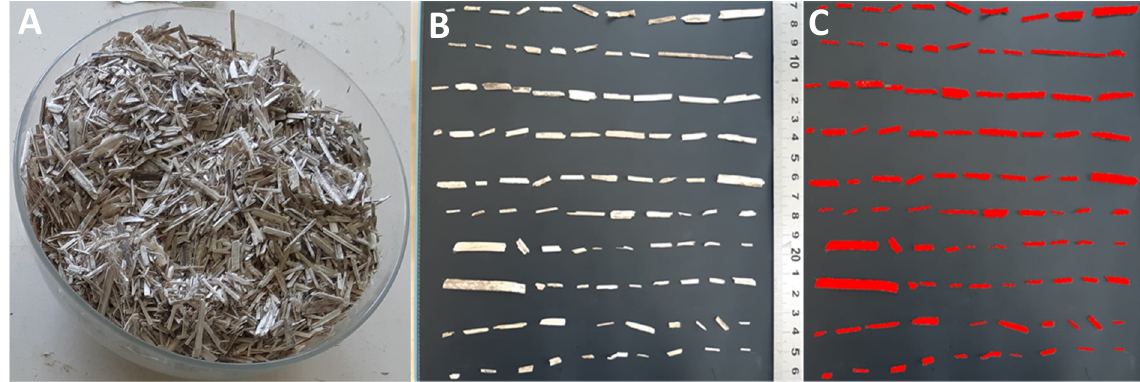
Figure 2. Raw hemp shiv fibers ( A ), length and thickness calculation of fibers ( B , C ). Hemp shiv length varies from 2 to 20 mm. Hemp shiv length variation is shown in Figure 3A. Figure 3B shows the length and thickness distribution of both fine and coarse hemp shiv particles.